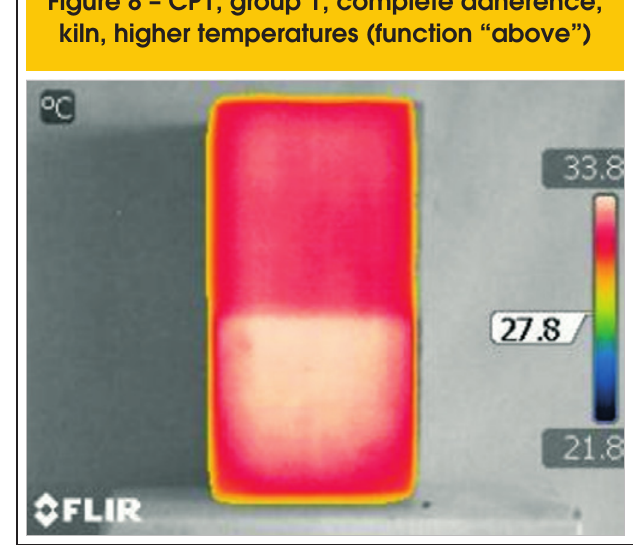
Figure 8 – CP1, group 1, complete adherence,